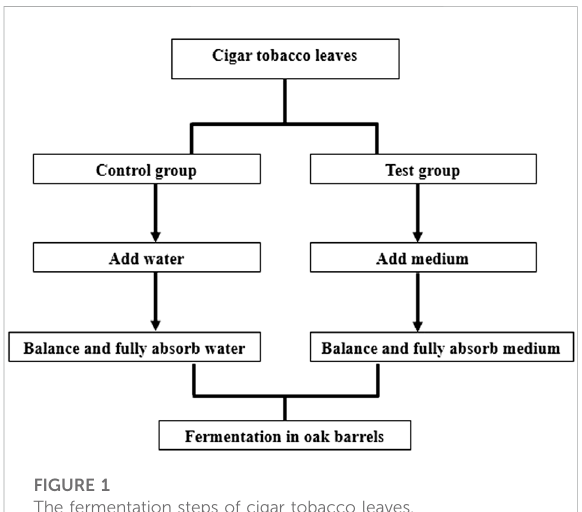
FIGURE 1 The fermentation steps of cigar tobacco